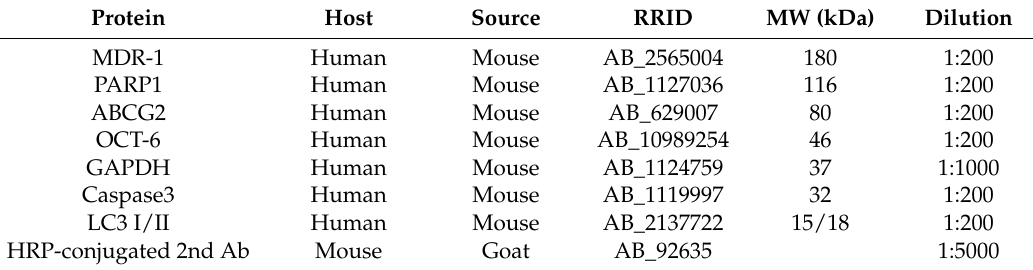
Table 1. Antibodies used in this